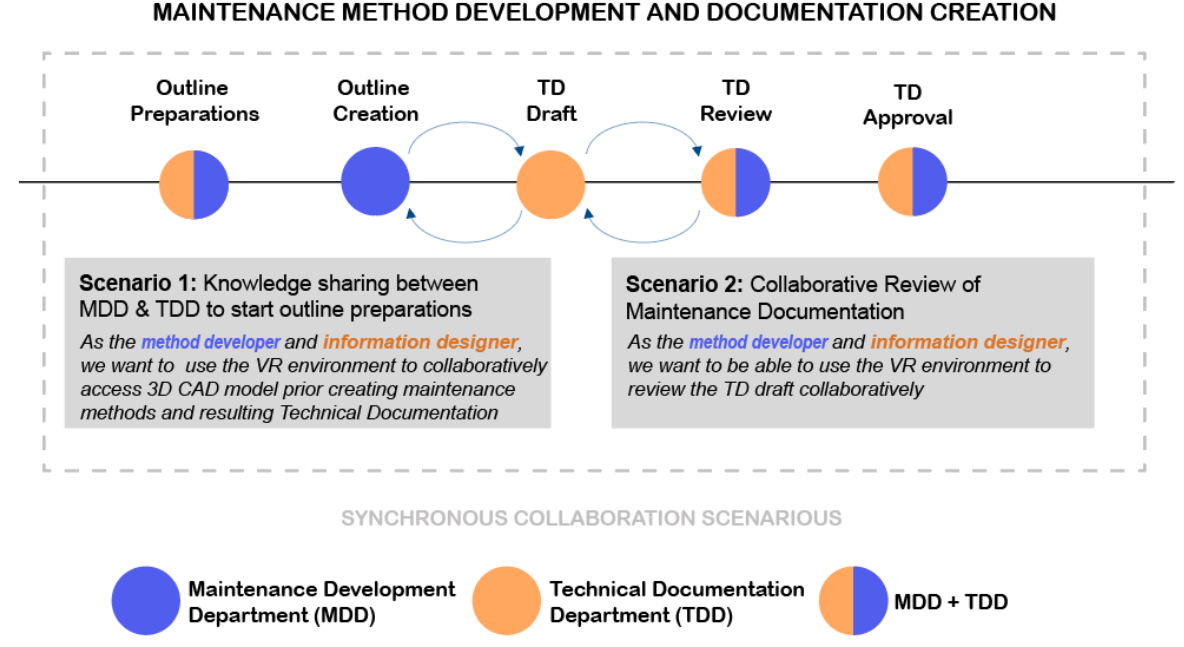
Figure 3. Maintenance Method Development and Technical Documentation creation.